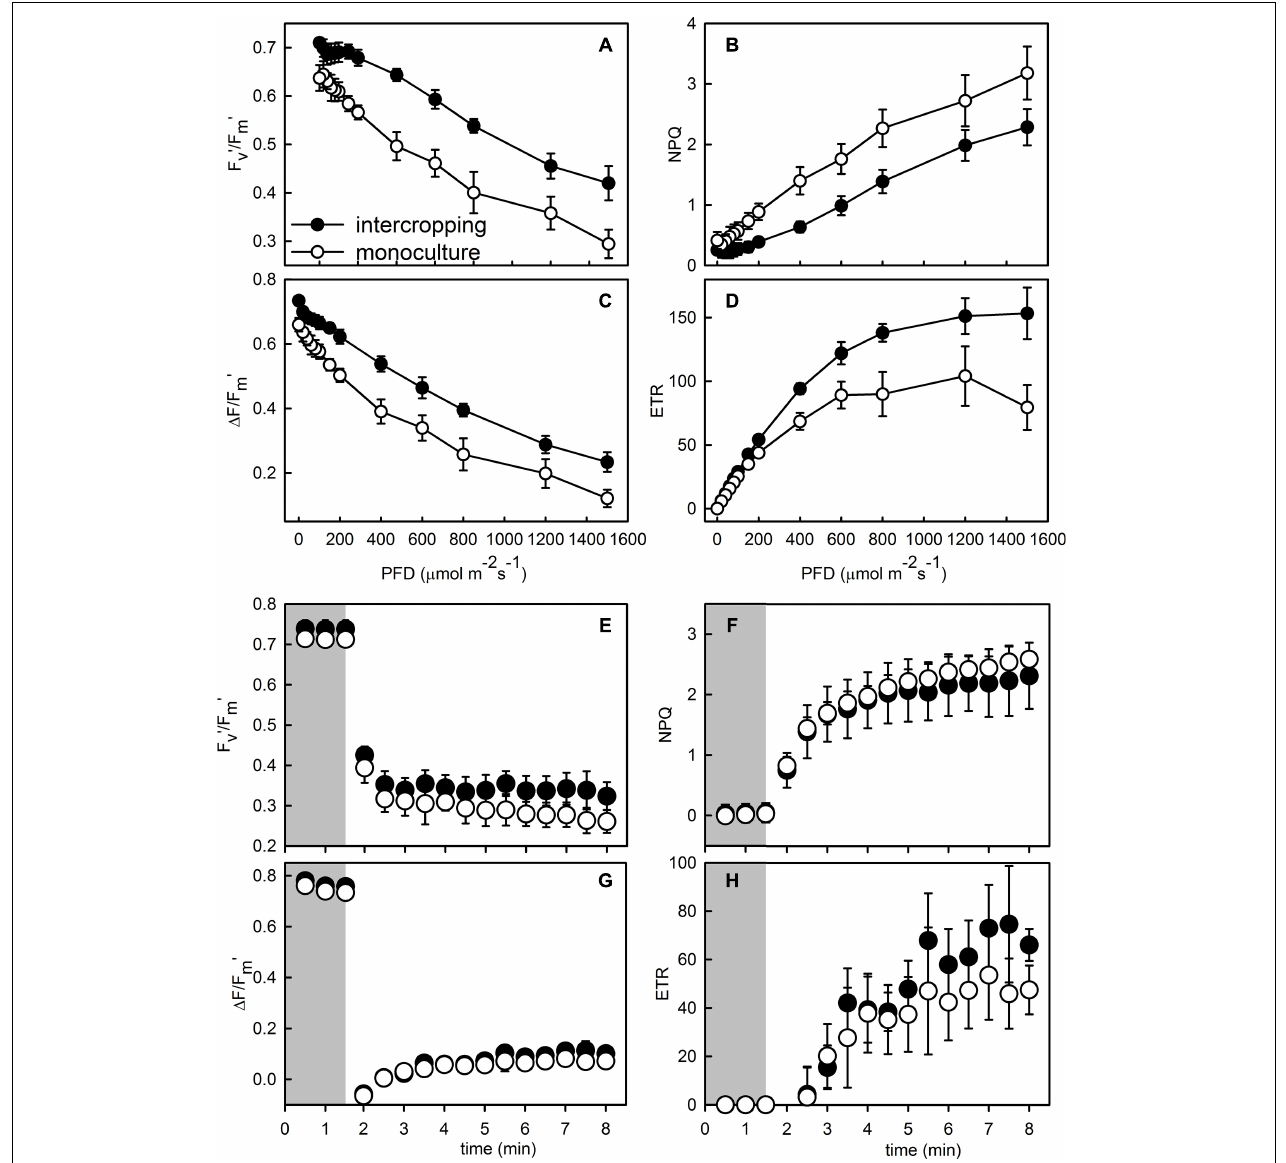
FIGURE 4 | Responses of maximum photochemical efficiency of PSII in the light ( F v (cid:48) / F m (cid:48) ), actual photochemical efficiency of PSII ( (cid:49) F / F m (cid:48) ), non-photochemical quenching (NPQ), and electron transport rate (ETR) to photo flux density (A–D) and the simulated sunfleck (E–H) in the leaves of morphophallus xiei grown under different cropping system. Each point is the mean ± SD of five replicates. Closed parts of responses to the simulated sunfleck indicate a response to low light, and open parts indicate a response to high